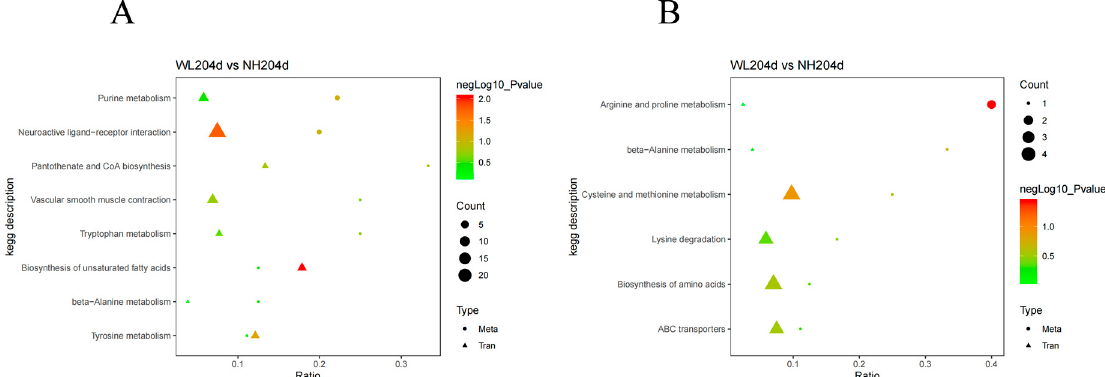
Figure 7. Common KEGG pathway enrichment map of the transcriptome and metabolome. ( A ) The common pathways in the negative model; ( B ) The common pathways in the positive mode.